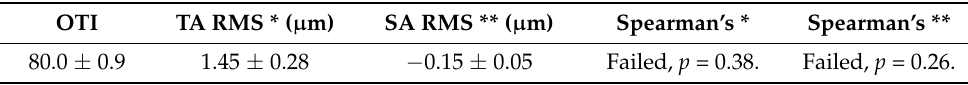
Table 3. Optical transparency index (OTI); Total aberration RMS (TA RMS); Spherical aberration RMS (SA RMS); and Spearman correlation analysis for the data collected from all participants of the study (* p < 0.05); ** p < 0.005).